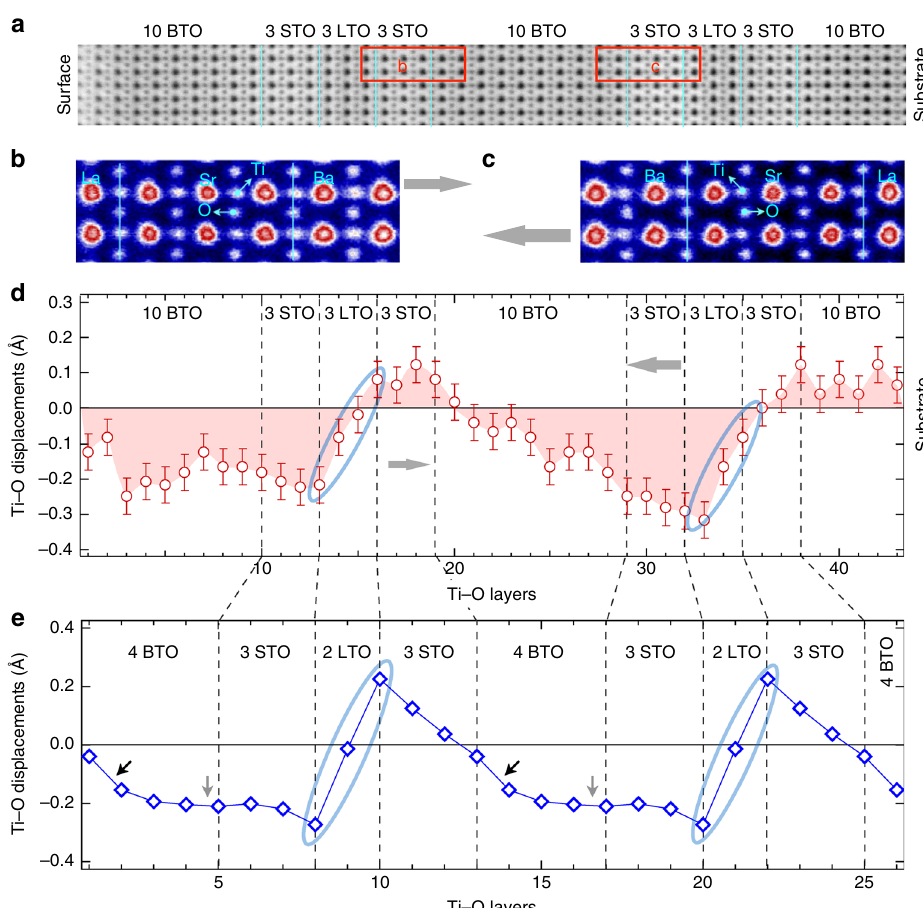
Fig. 3 Polar displacements. a ABF-STEM image of 10BTO/3STO/3LTO along [110] direction. b , c Enlarged images of red rectangular areas in a showing atomic positions of Ba, Sr, La, Ti, and O ions across interfaces. Gray arrows (in b – d ) indicate the reversal directions of Ti – O polar displacements. d Experimentally layer-resolved Ti – O polar displacements in a 10BTO/3STO/3LTO superlattice. Here the Ti – O polar displacements (or Δ Ti – O ) are de fi ned as oxygen displacement with respect to Ti along the out-of-plane. The error bar shows the standard deviations of the averaged measurements for each vertical atomic layer. e Theoretically layer-resolved Ti – O polar displacements in a 4BTO/3STO/2LTO superlattice. Black and gray arrows indicate negative and zero slopes of the Ti – O displacements, respectively, in BTO layers, whereas blue ellipses highlight positive slopes in LTO